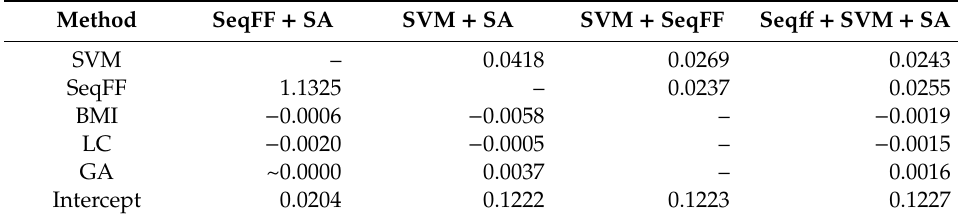
Table 1. The table shows corresponding feature weights of four trained linear models. Each row represents a single feature of a linear model and each column represents a specific model. Each model has a different combination of features. If a feature is not part of the model, the value is empty (labeled by dash). Since one hundred models were trained for each combination, only the model with median correlation is displayed. SVM: support vector machine estimator prediction based on fragment length profile. SeqFF: prediction of the SeqFF model. BMI: body mass index of the mother. LC: DNA library concentration. GA: gestational age. SA: sample attributes (BMI + LC + GA).